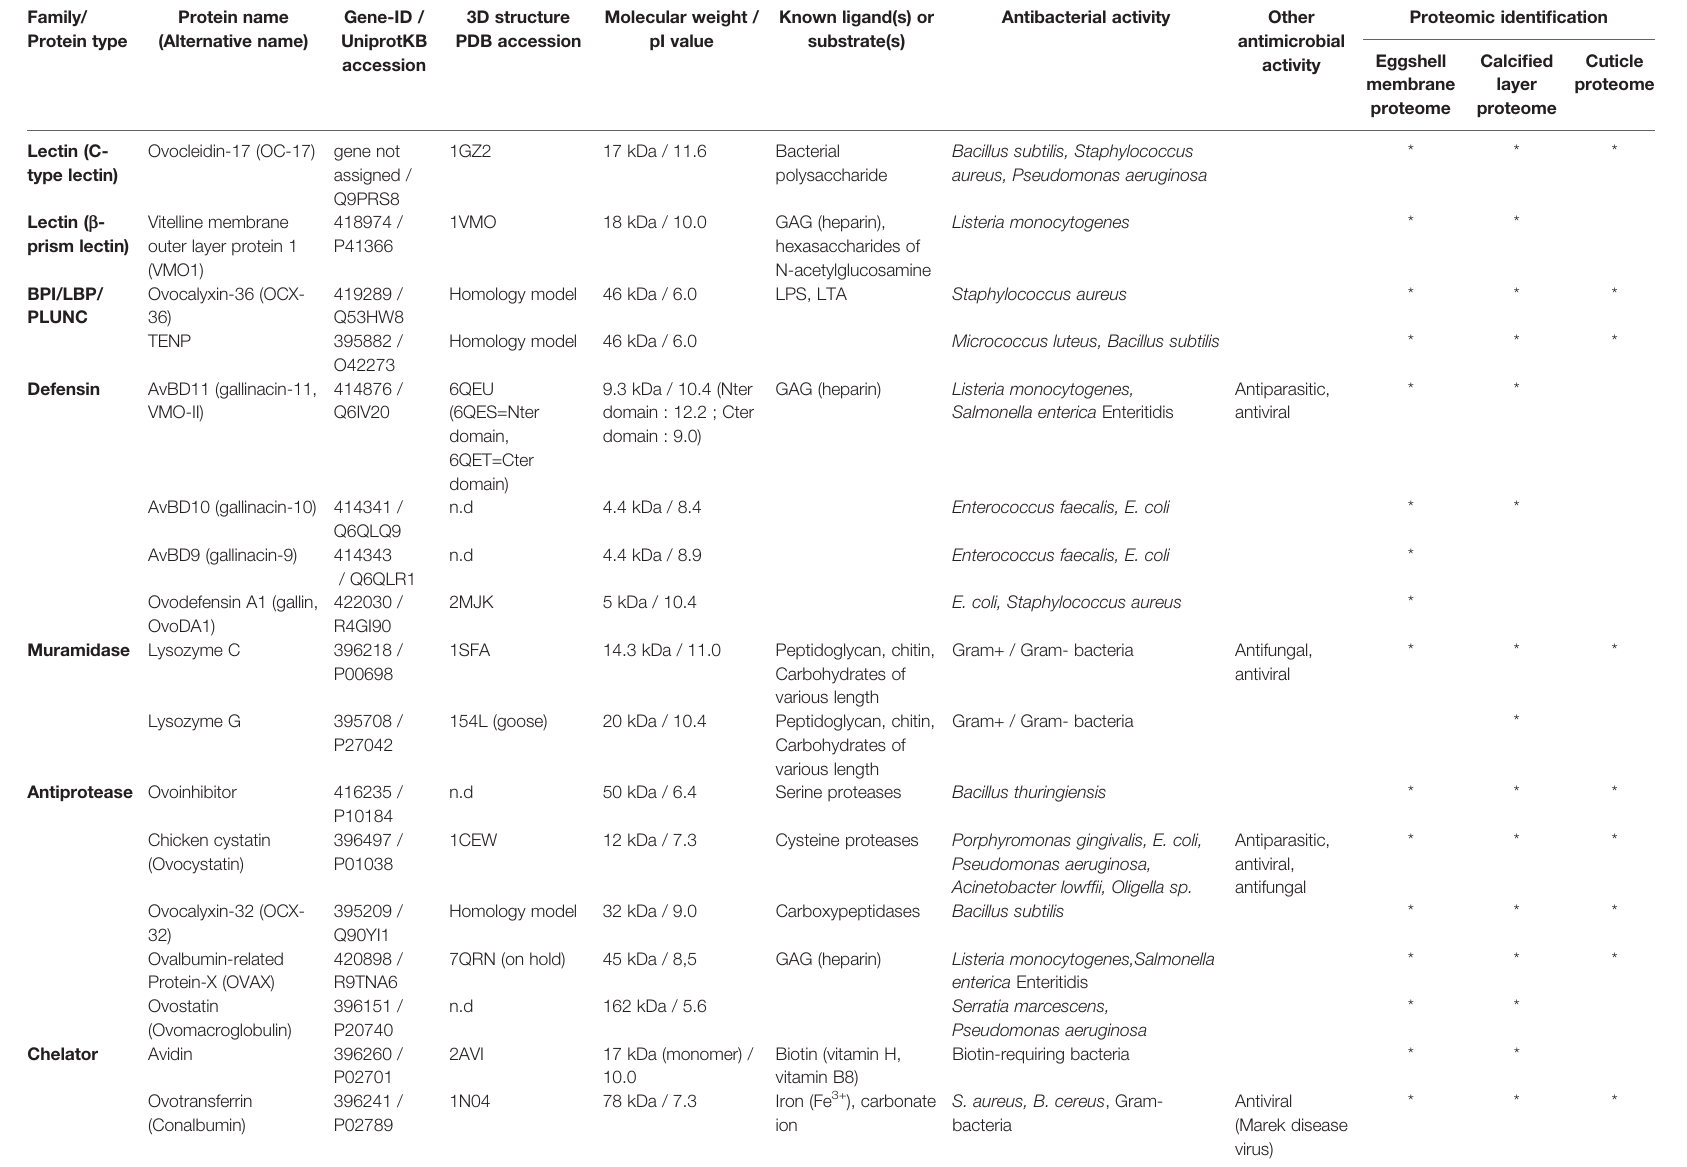
TABLE 1 | List of antimicrobial proteins and peptides identi fi ed in chicken eggshell by mass spectrometry. Family/ Protein type